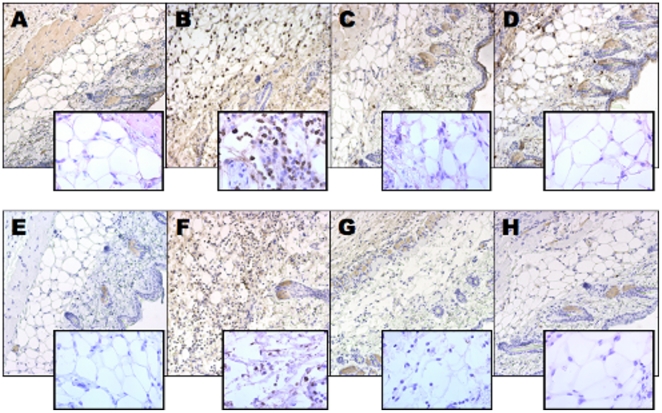
Topical SAGE reduces PMN infiltration and S100 calgranulin accumulation from intradermal LL-37.LL-37, PBS and LL-37 and SAGE-injected mouse skin was stained with antibody to mouse Gr-1 to examine neutrophil infiltration, and also for S100A8 calgranulin, the major RAGE-binding calgranulin present in murine PMNs [17] as described in Methods. A. Staining of normal control skin for the PMN antigen Gr-1. B. Staining of LL-37 injected skin for the PMN antigen Gr-1. C. Staining of skin injected with LL-37 plus GM-1111 (applied at t = 0) for the PMN antigen Gr-1. D. Staining of skin injected with LL-37 plus GM-1111 (applied at t = 12 h) for the PMN antigen Gr-1. E. Staining of normal control skin for the RAGE ligand S100A8. F. Staining of LL-37 injected skin for the RAGE ligand S100A8. G. Staining of skin injected with LL-37 plus GM-1111 (applied at t = 0) for the RAGE ligand S100A8. H. Staining of skin injected with LL-37 plus GM-1111 (applied at t = 12 h) for the RAGE ligand S100A8. Figures and insets are shown at 20x and 40x magnification, respectively.